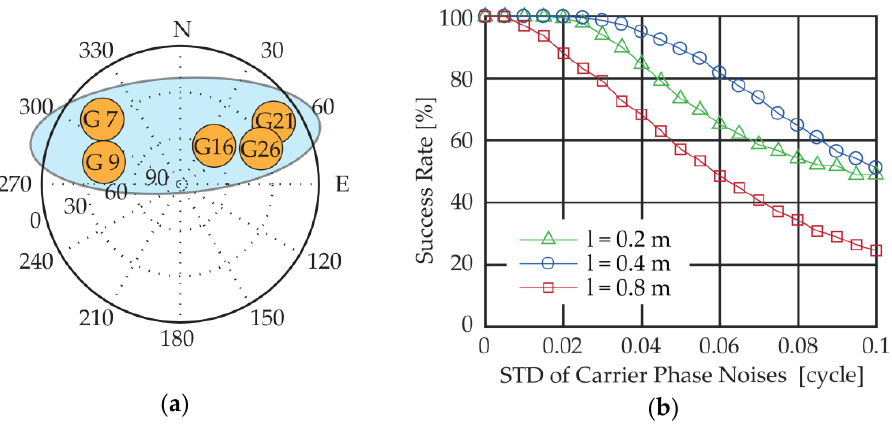
Figure 6. ( a ) Poor Satellite geometry distribution; ( b ) Success rates of the MSR method under (a).